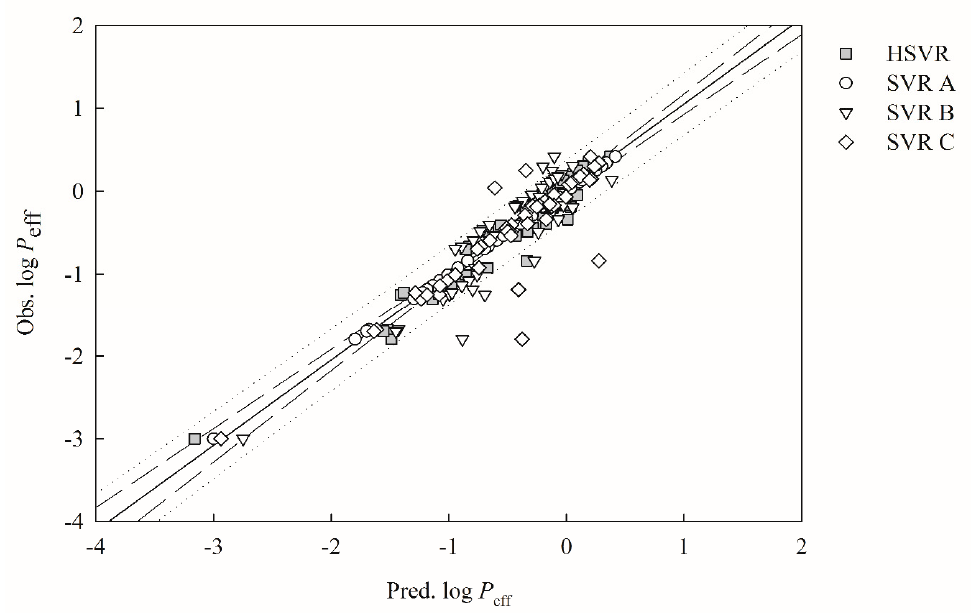
Figure 2. Observed log P e ff vs. the log P e ff predicted by SVR A (open circle), SVR B (open triangle), HSVR SVR C (open diamond), and HSVR (gray square) for the molecules in the training set. The solid line, dashed lines, and dotted lines correspond to the HSVR regression of the data, 95% confidence intervals for the HSVR regression, and 95% confidence interval for the prediction, respectively.